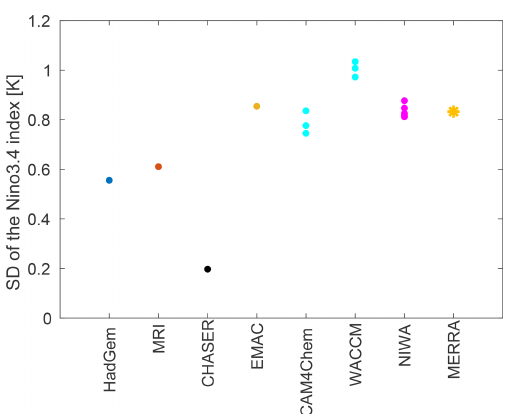
Figure 1. Standard deviation of surface temperature in the Nino3.4 region in the CCMI models. The multiple dots for NIWA, WACCM, and CAM4Chem represent different integrations of the same model. The standard deviation in CHASER is much less than that observed, and hence this model was excluded from further